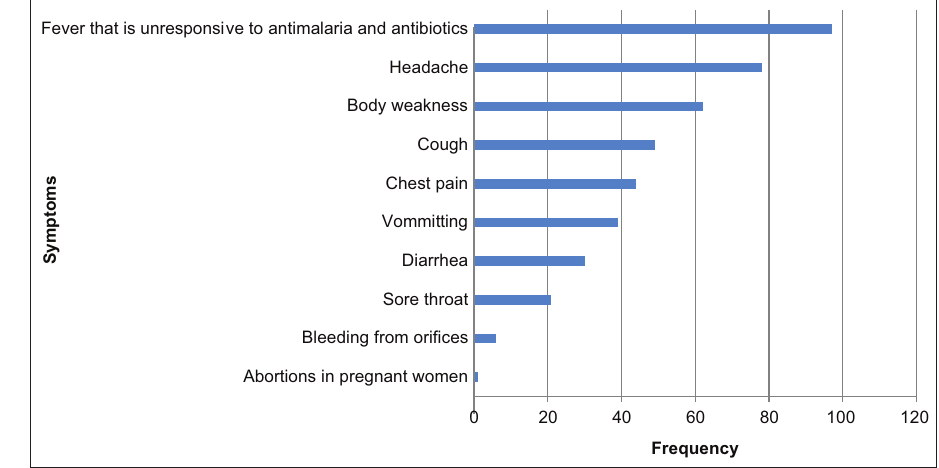
Figure-2: Symptoms of Lassa fever infection among Table-2: Recognized risk factors of Lassa fever and measures to prevent recurrence among respondents. Risk factors